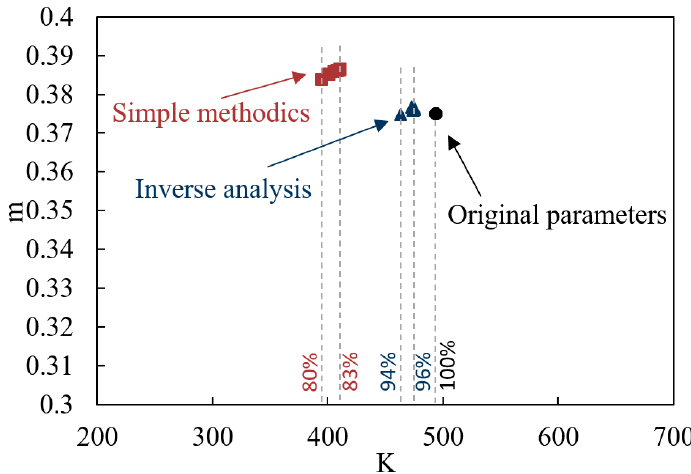
Figure 8. (cid:1837),(cid:1865) parameters, obtained by FE simulation processing. Figure 8. K , m parameters, obtained by FE simulation